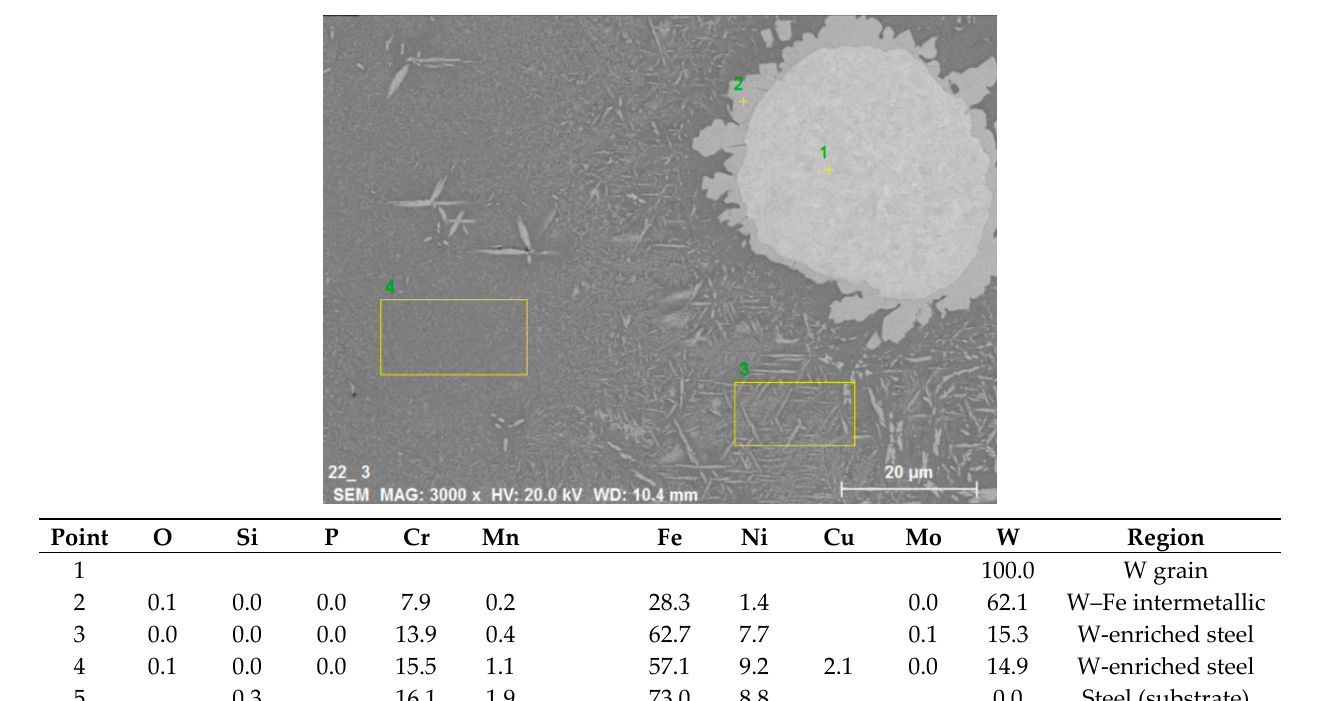
Figure 7. Cross sections of W–Cu cladding made from 75% W mixture on a steel substrate: ( a ) overview near the top, ( b ) overview near the substrate, ( c ) detail of a middle region (light microscopy for better distinction of the Cu grains in the steel matrix).